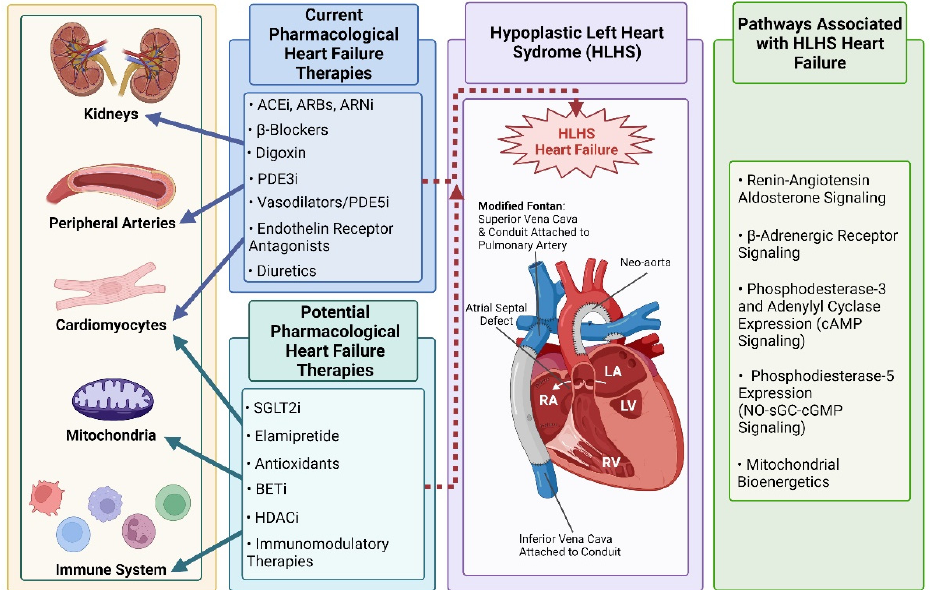
Figure 1. Current pharmacological therapies and potential novel therapeutic targets that could modulate Hypoplastic Left Heart Syndrome (HLHS)—associated heart failure (HF). Current commonly used adult HF therapies have demonstrated mixed or inconclusive effects on HF risk and patient outcomes in the HLHS population. Targets implicated in HLHS HF that could be amenable to pharmacological treatment and improve outcomes for HLHS patients are summarized. Created with BioRender.com (accessed on 24 April 2022).